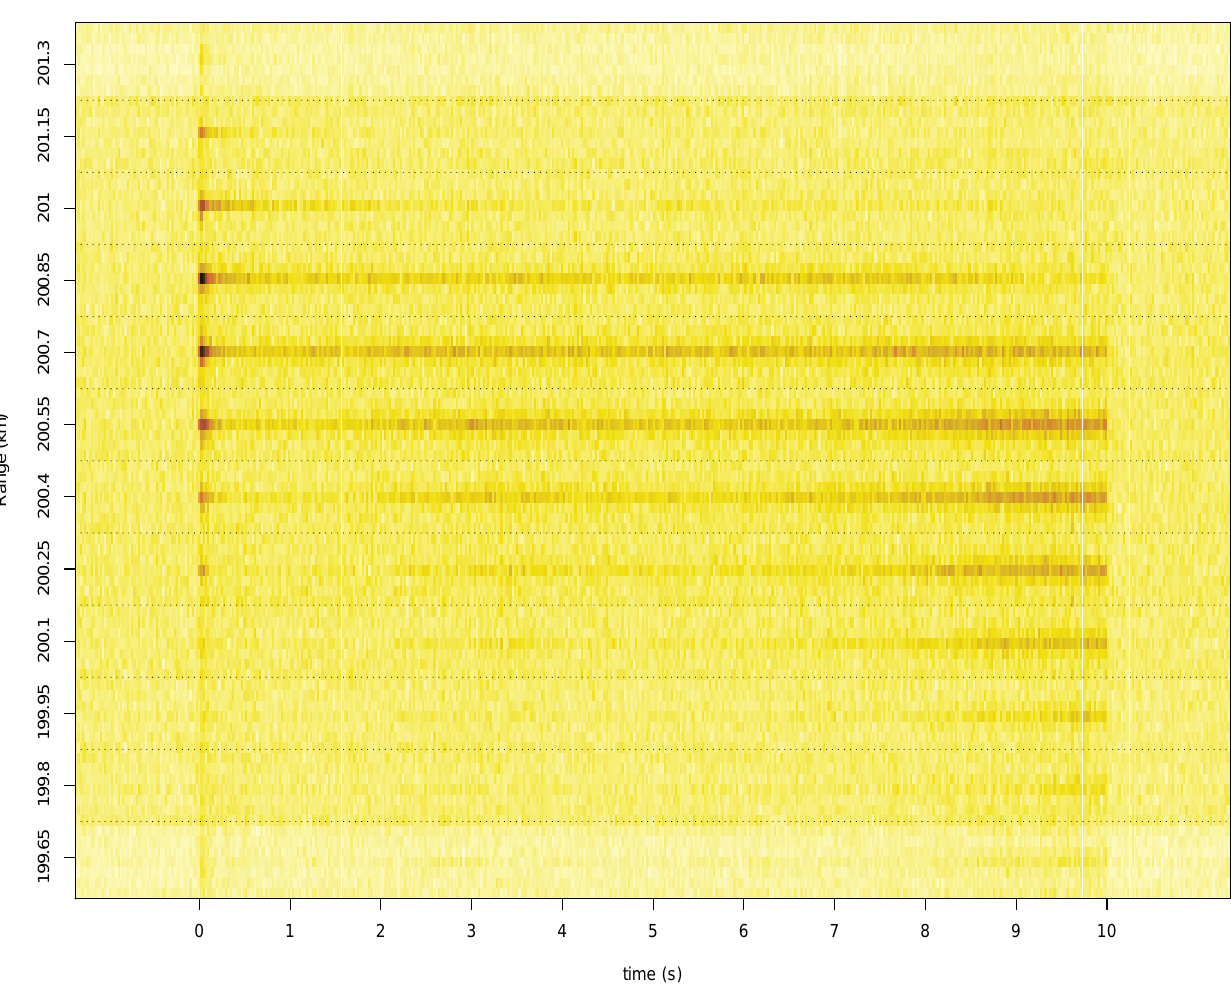
Fig. 4. Heating in the F-region at 150m resolution from one heating period starting from 10:45:20. The temporal resolution is approximately 2 . 5ms (uneven IPPs). The figure contains the modulus of one set of spectral parameters for each transmit pulse, the values are in linear scale. The values are the statistically most probable values given the measurements. Each range gate is represented with a ± 20kHz spectrum at a 6 . 67kHz frequency resolution. The spectrum is dominated by one central peak. The heated layer is completely contained within a 1.8km range interval and most of it is within a 600m region. After recovering from the strong overshoot in the beginning, the heated region moves down at about 45m/s during a single 10s heating period. The spectrum seems to broaden and strengthen slightly towards the end of the heating